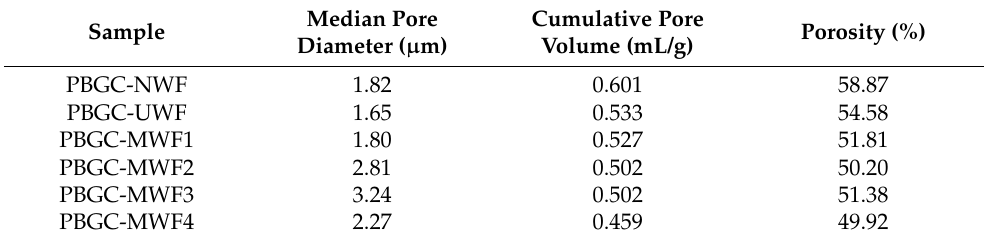
Figure 10. The pore size distribution and cumulative pore volume of all the PBGCs. ( a ) Pore size distribution; ( b ) cumulative pore volume.